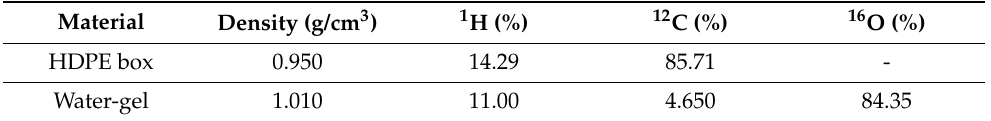
Figure 1. Schematic diagram showing PEM heads and HPDE box containing water-gel being irradi- ated by a proton beam. Table 1. Density and material composition (fraction by weight) of HDPE container and water-gel used in the proton irradiation experiment and PEM